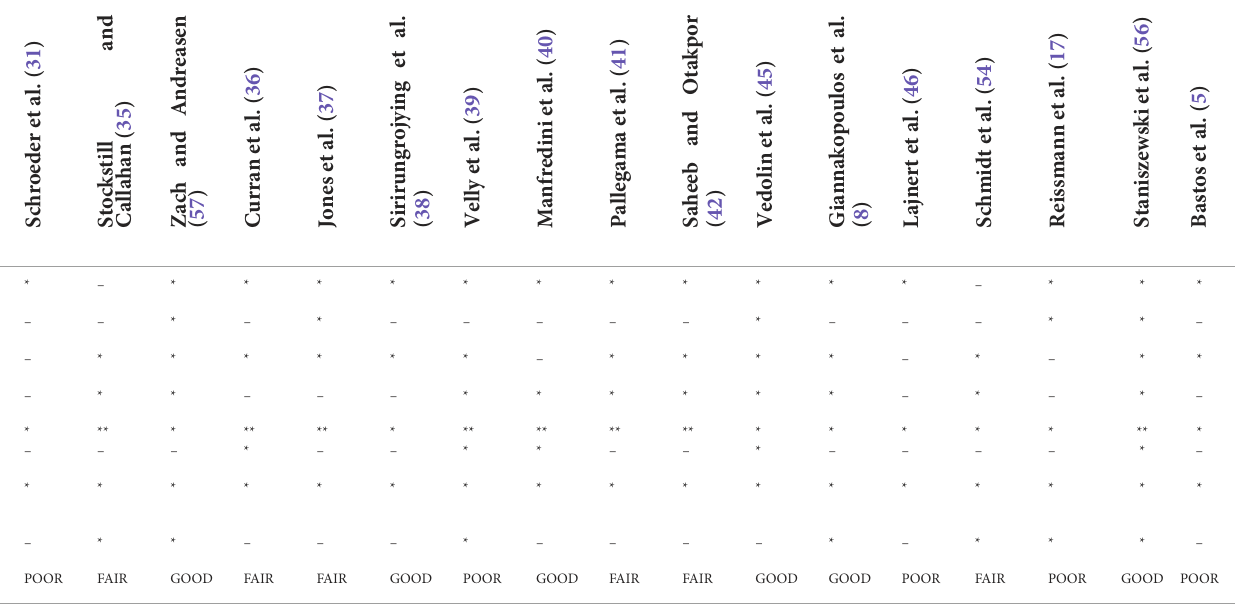
TABLE 3 Newcastle-Ottawa Scale for case-control